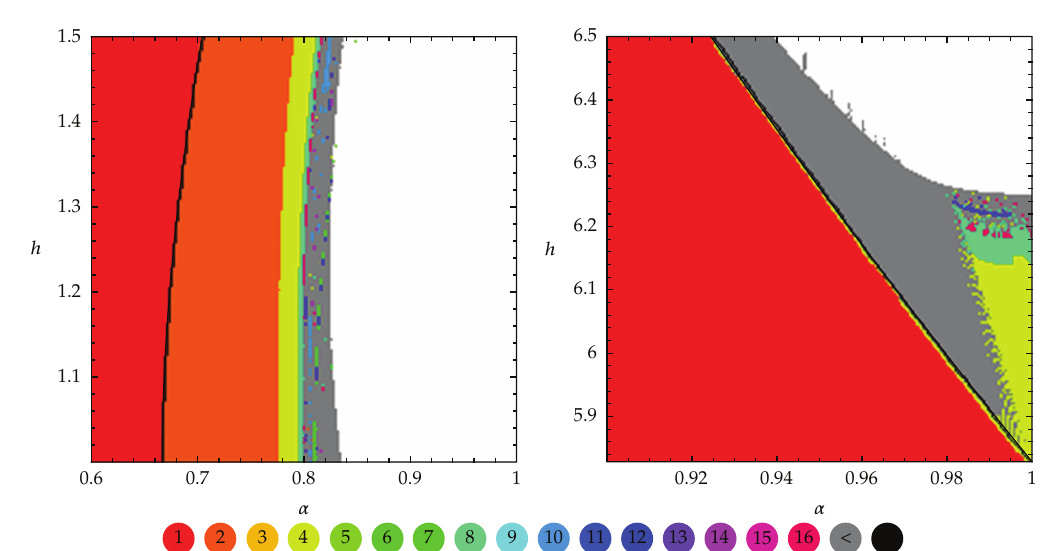
Figure 2: Bifurcation diagrams in the (cid:2) α,h (cid:3) plane for the two-group model (cid:2) a (cid:3) and for the two-firm model (cid:2) b (cid:3)